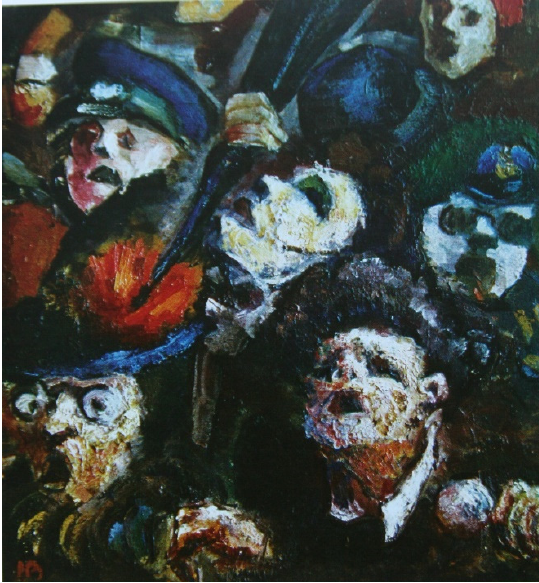
Figure 9. A. Gluskin. To the Demonstration . 1932.